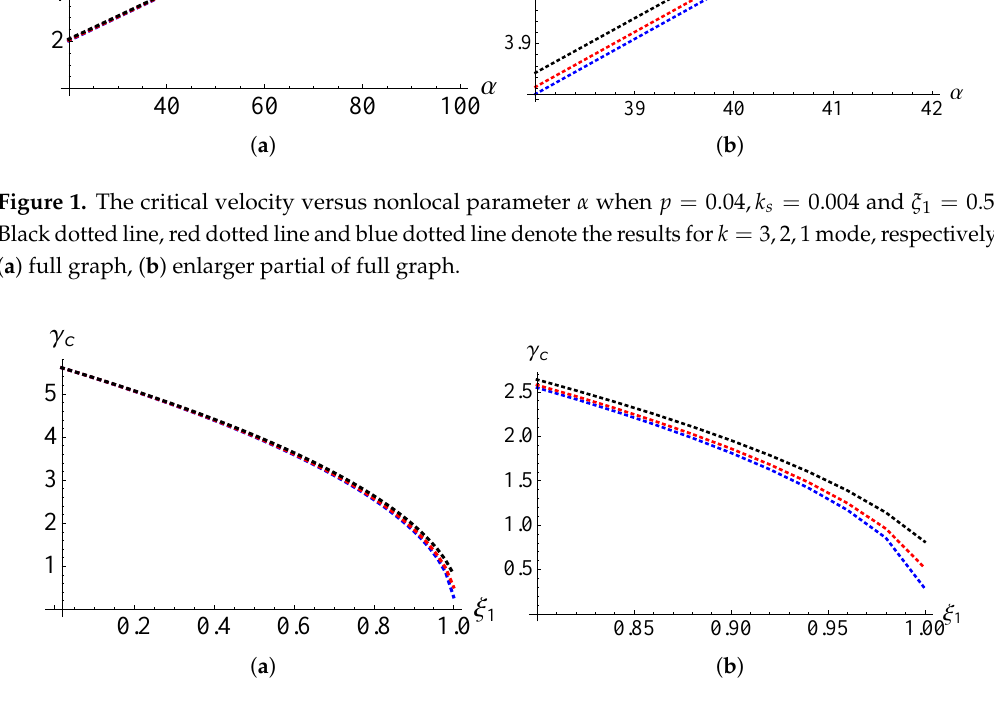
Figure 2. The critical velocity versus volume fraction ξ 1 when p = 0.04, α = 40, k s = 0.01. Black dotted line, red dotted line and blue dotted line denote the results for k = 3,2,1 mode, respectively. ( a ) full graph, ( b ) enlarger partial of full